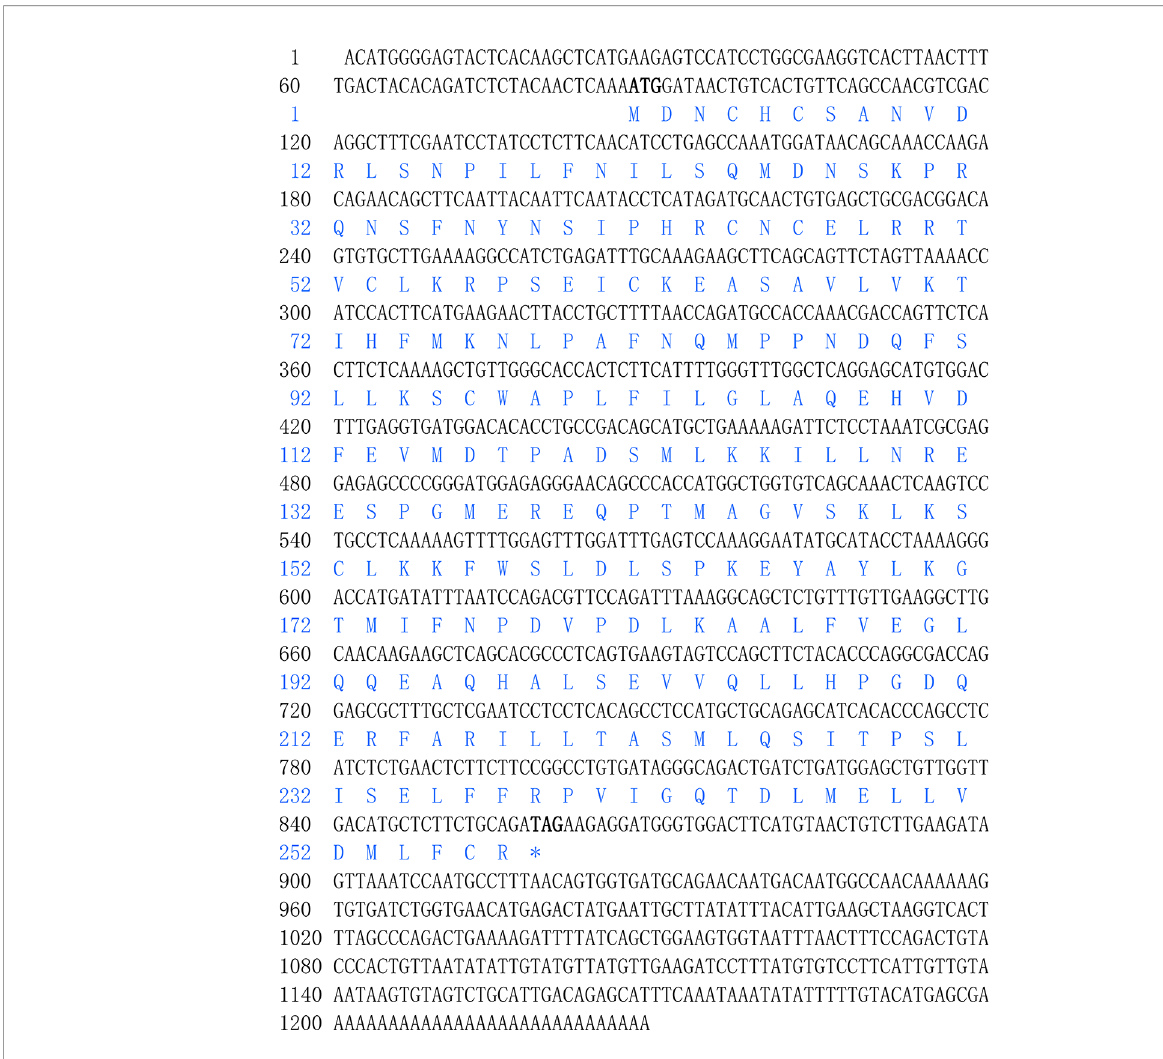
FIGURE 1 | Nucleotide and deduced amino acid sequences of SHP of large yellow